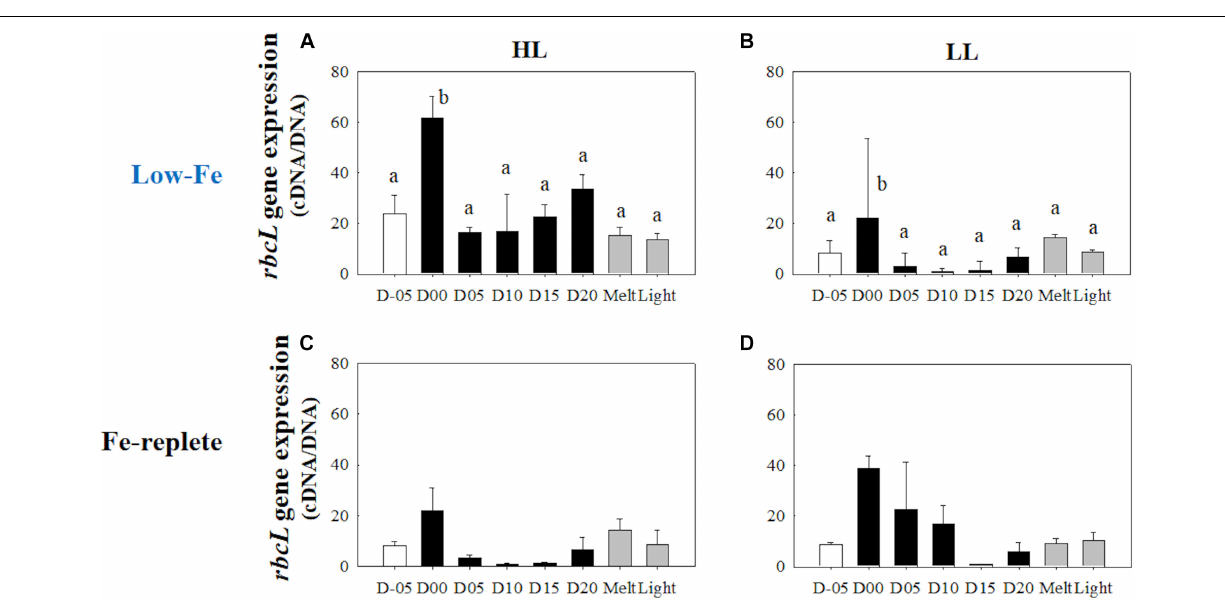
FIGURE 12 | Gene expression of the rbcL gene. Panels (A,B) show rbcL gene expression of the low-Fe ice tank runs in this study, whereas panels (C,D) show those of Fe-replete ice tank runs modified from Yoshida et al. (2020). Left (A,C) and right (B,D) panels indicate data from the HL and LL treatments, respectively. Open, closed, and shaded bars indicate values of pre-freeze seawater, ice, melted seawater samples, respectively. Letters above bars in a panel indicate significant differences in values between sampling days with one-way ANOVA with Tukey’s test; there is no significant difference between values if a given letter is shown in the combination of letters of the counterparts. The D stands for “day,” while Melt and Light indicate values after melting and light exposure experiments, respectively. Error bars show 1 standard deviation ( n = 3). One-way ANOVA with Tukey’s test, HL: F ( 7 , 23 ) = 14.94, p < 0.001; LL: F ( 7 , 23 ) = 8.36, p < 0.001. Two-way ANOVA test with Tukey’s test, Light: F ( 1 , 45 ) = 7.74, p < 0.001; Day: F ( 7 , 45 ) = 1.00, p > 0.05; Light*Day: F ( 7 , 45 ) = 0.79, p > 0.05. The results of Tukey’s test, as q -values, are given in the